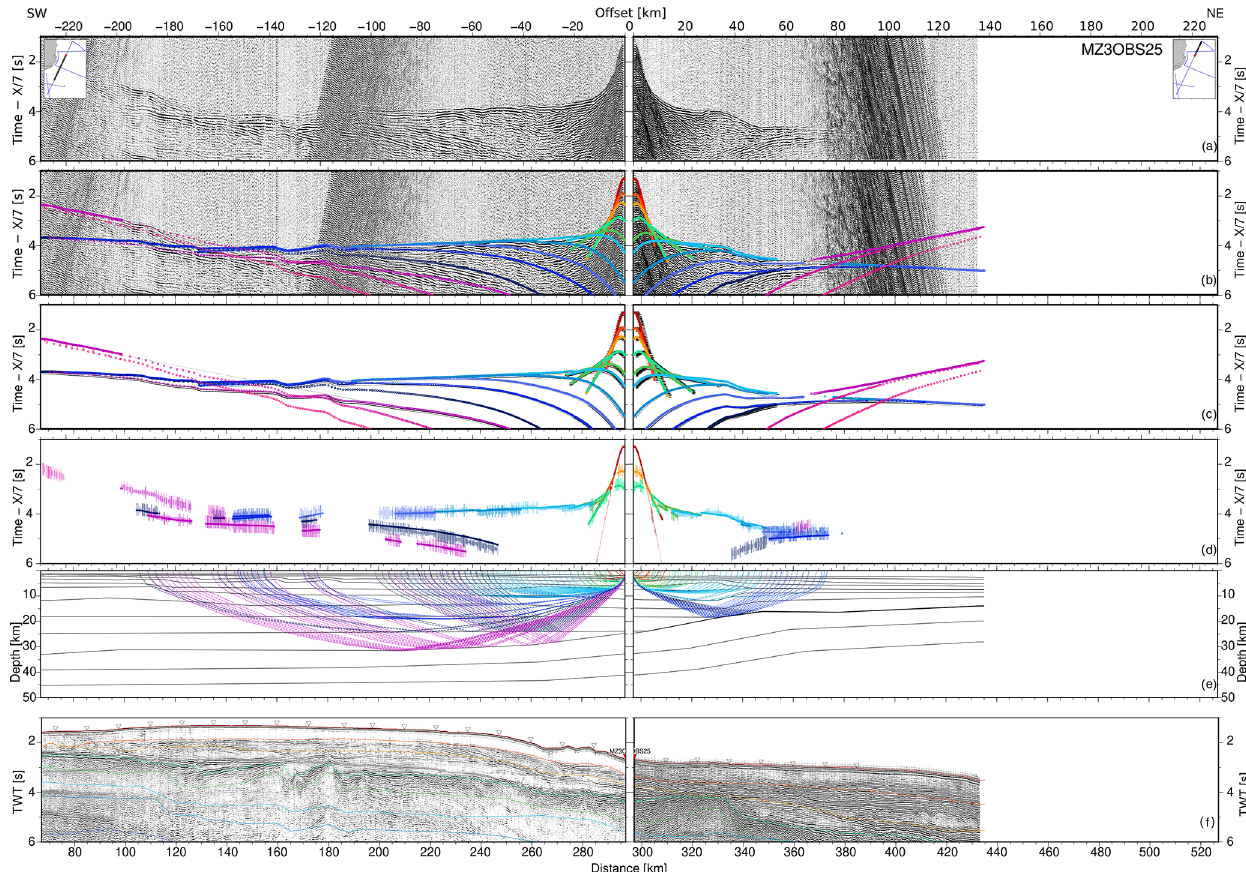
Figure 6. Seismic phases from the crust and mantle on MZ3OBS25. The left-hand panels represent negative offsets (toward the SW), and the right-hand panels represent positive offsets (toward the NE). On each side, the six panels display (a) seismic record, (b) seismic record with color-coded predicted arrivals, (c) synthetic section with color-coded predicted arrivals, (d) color-coded picked travel times with uncertainty bars overlain by dotted predicted times, (e) color-coded seismic rays, and (f) MCS time-migrated section with color-coded model interfaces. (a–d) Travel time is reduced by a velocity of 7kms − 1